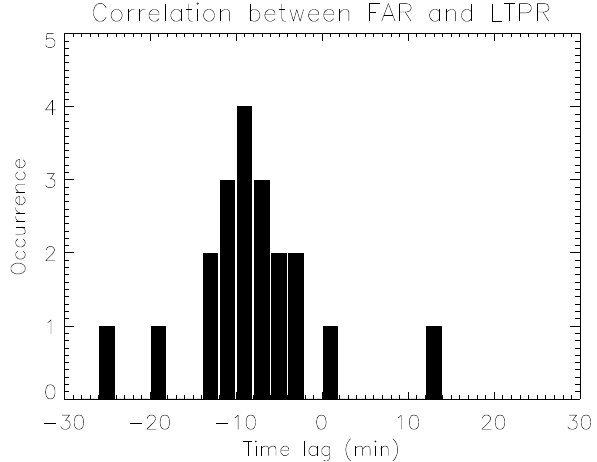
Fig. 5. Distribution of lag time between echoes observed by the LTPR and the FAR. Positive lag means that the LTPR detects echoes prior to the FAR.